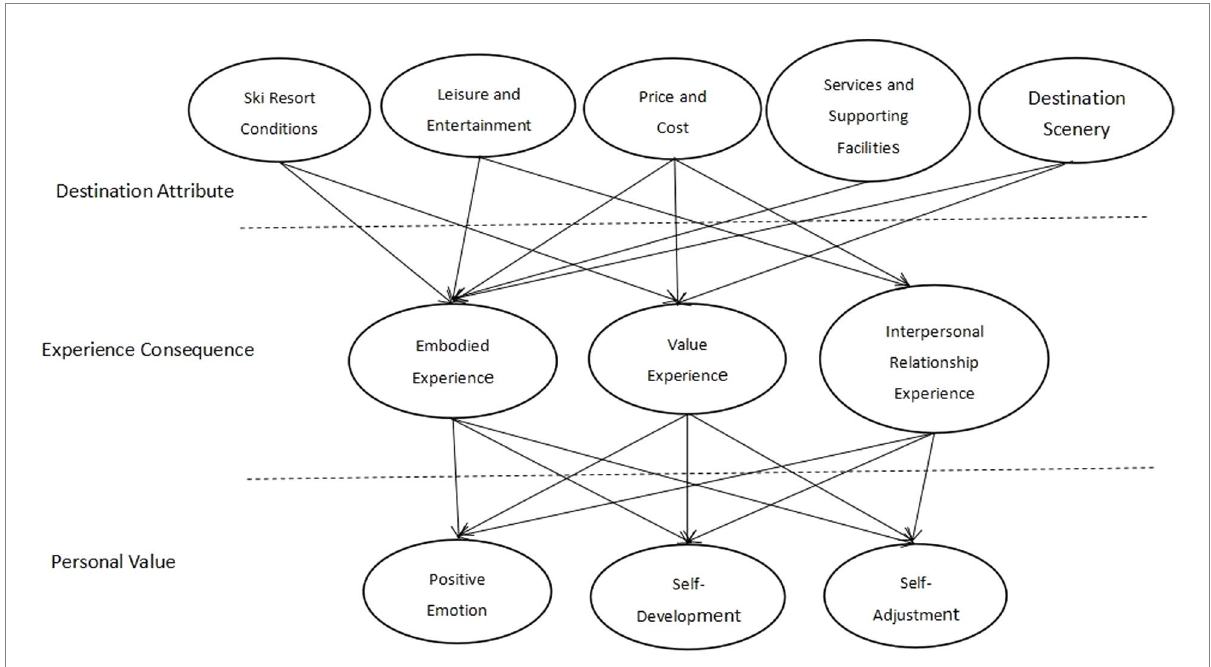
FIGURE 1 Value hierarchy diagram of influencing factors of ski tourism enthusiasts’ destination